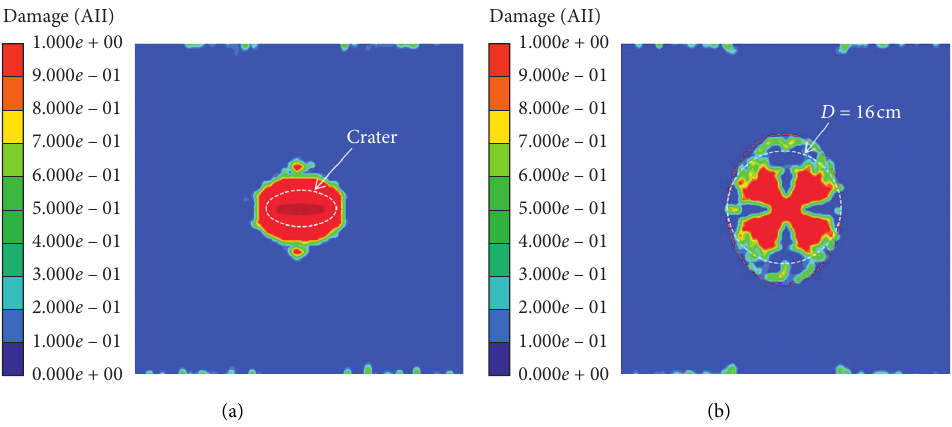
Figure 18: Simulation results under cylindrical explosive. (a) Upper surface. (b) Bottom surface.